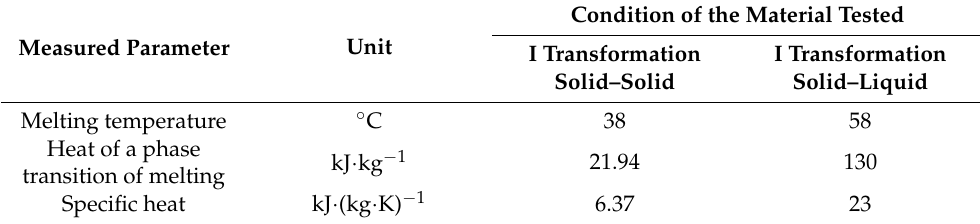
Table 2. Physical parameters of paraffin